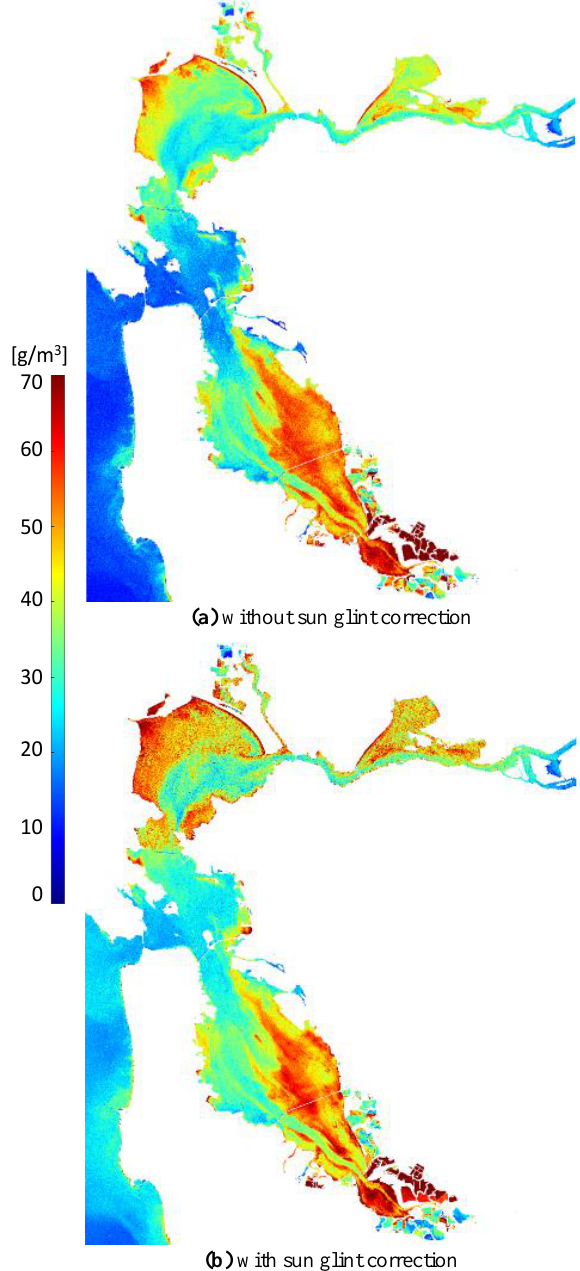
Figure 8 . TSM maps derived from NN without and with the sun glint